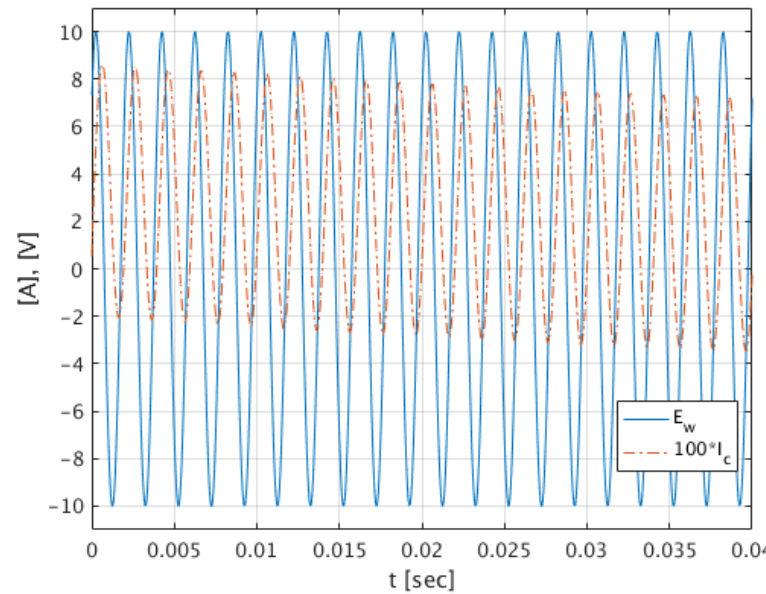
Figure 10. The waveform of the choke current I c ( ∗ 100 ) and voltage supplying the choke E w for angular frequencies ω = 3141.6 rad after switching it s